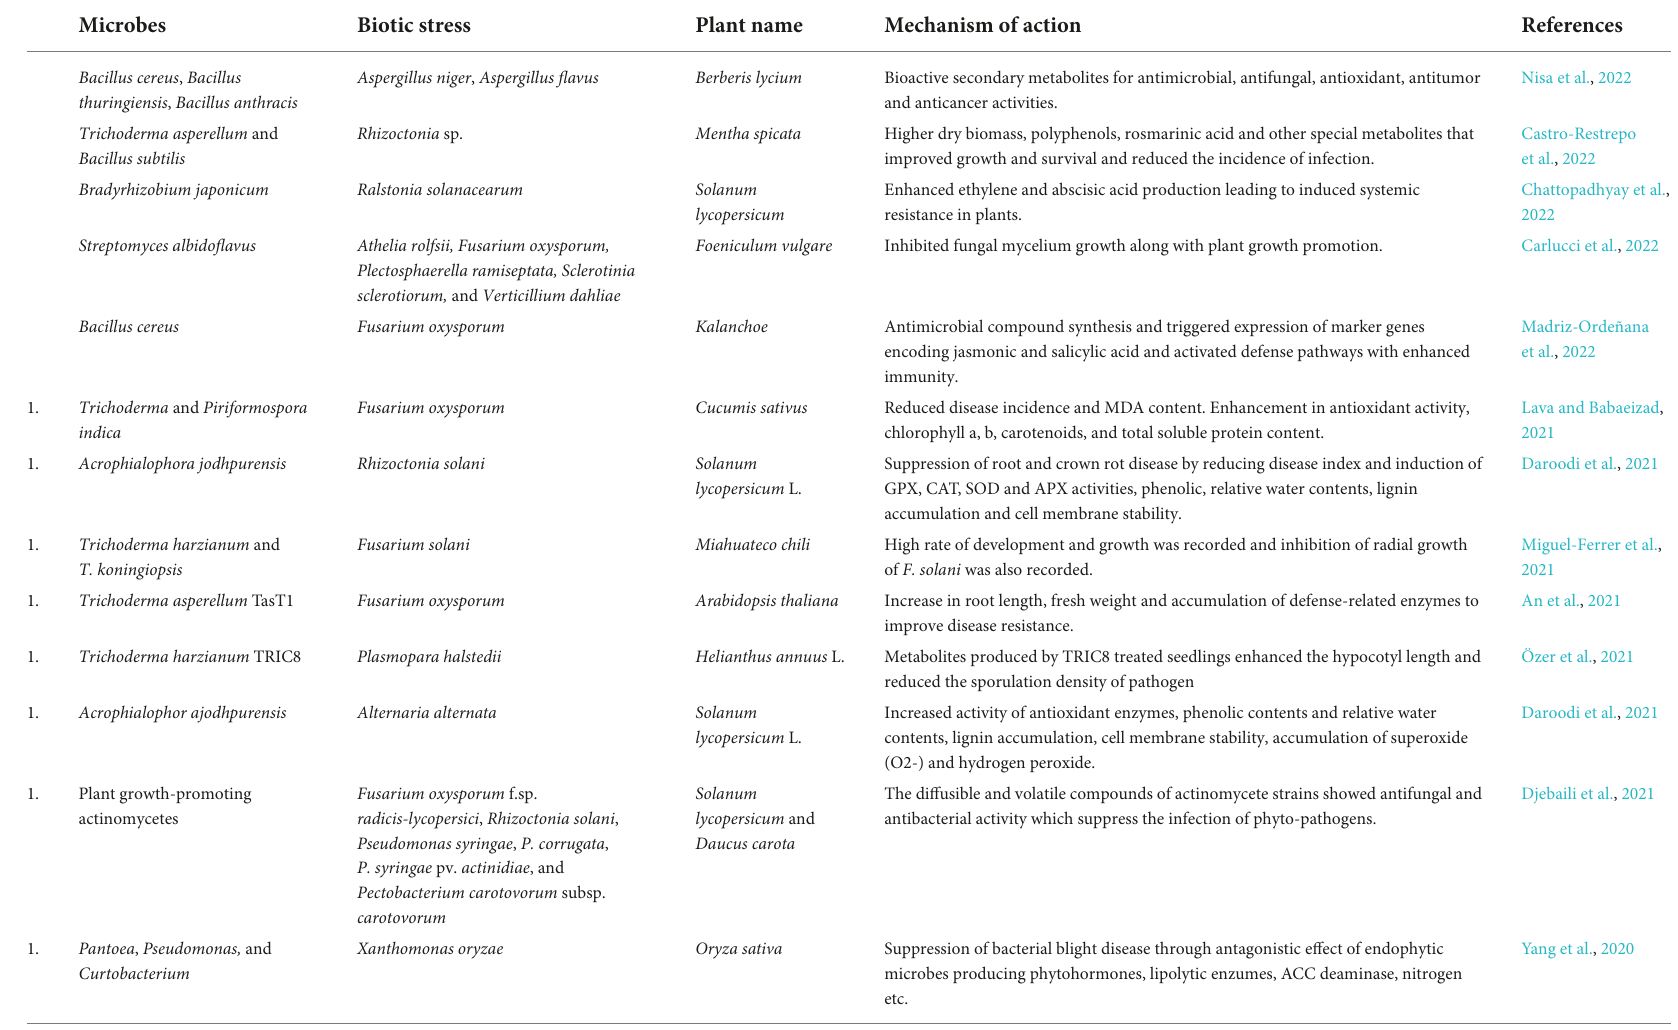
TABLE 3 Mechanisms adopted by different microbes in plants for biotic stress